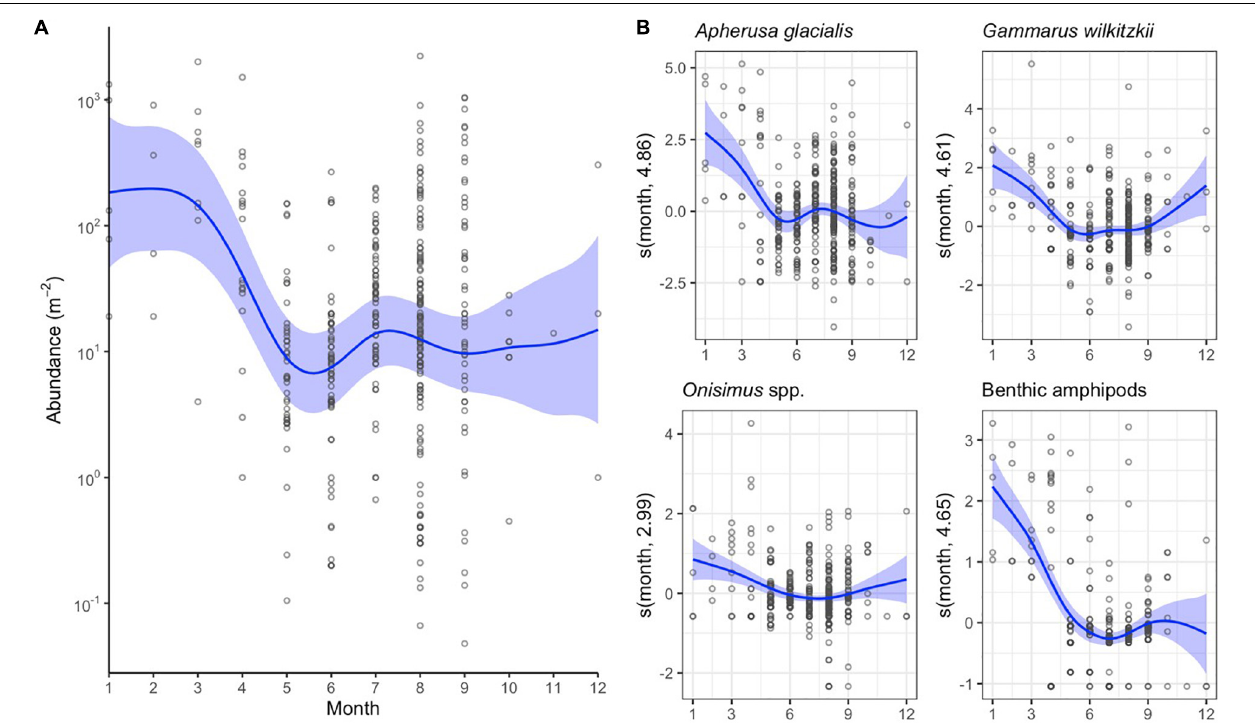
FIGURE 5 | Monthly changes in sympagic crustacean abundance as indicated by the general additive mixed models (GAMM). (A) Changes in total abundance of sympagic crustaceans (excluding benthic amphipods). (B) GAMM models for abundance of four amphipod taxa. See Figure 4 for additional